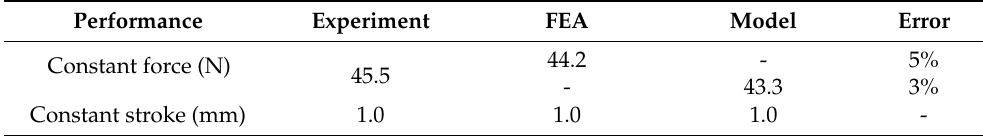
Table 3. Analysis of results in the constant force